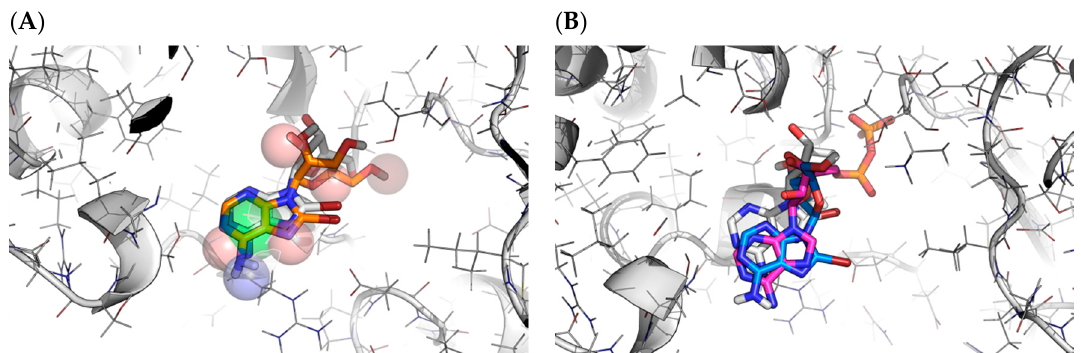
Figure 9. Predictions for PDB 6dfo and hiTanimoto Receptor using: ( A ) Pharmacophoric restraints. Predicted pose in orange. Pharmacophore represented as spheres. ( B ) Tether docking. Predicted pose in blue. Reference ligand in pink. In both cases, the crystallographic solution is shown in white for reference. The RMSD values with the predicted poses are 1.2 Å and 3.3 Å, respectively.